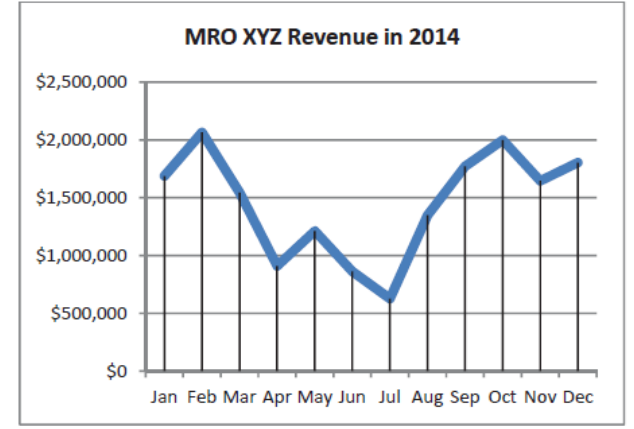
Figure 5 : MRO XYZ Revenue from base maintenance in 2014; Source: (Saltoglu et. Al.,